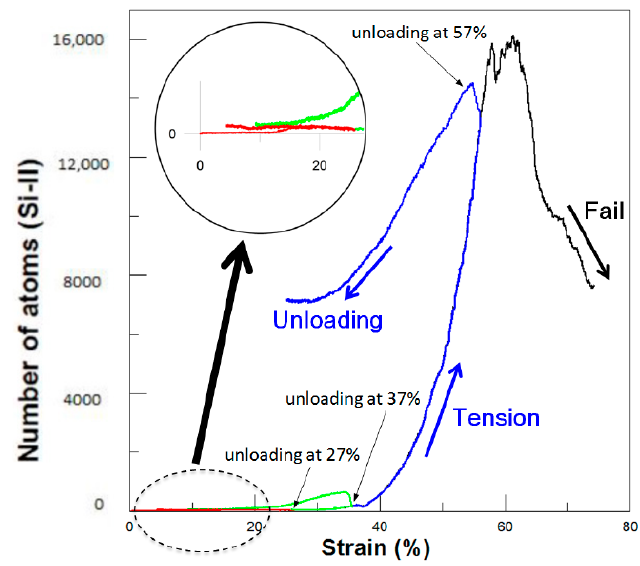
Figure 16. Number of Si-II atoms versus strain curve (unloading at strain of 27%: red; 37%: green; 57%: blue; without unloading: black).